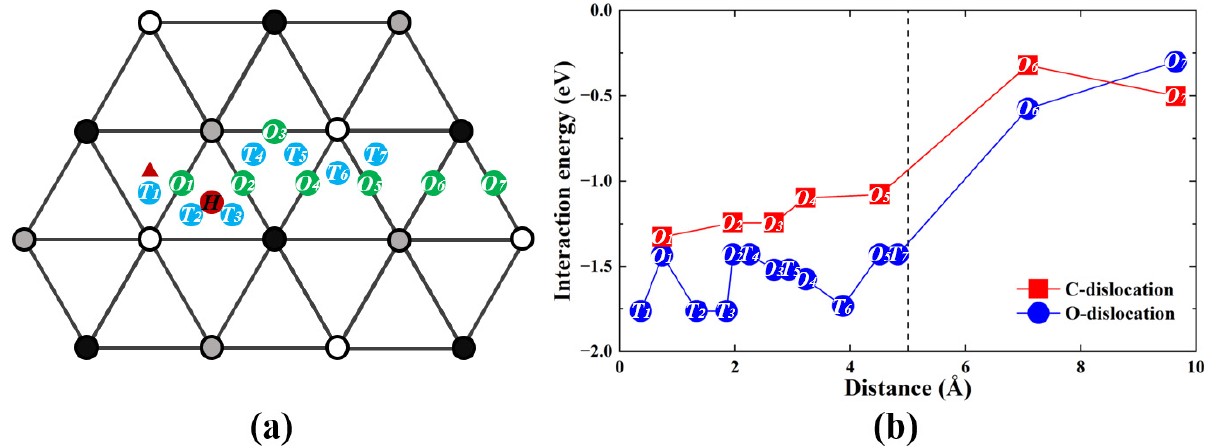
Figure 2. ( a ) Projection along the (111) plane for pure Mo dislocation. The position of dislocation is marked with the red triangle and the position of the reconstructed hard core is marked with H. A total of 7 octahedral-like ( O 1 – O 7 ) and tetrahedral-like ( T 1 – T 7 ) interstitial sites around the dislocation core in pure Mo (without the relaxation of the solute–dislocation interactions) are represented in different colors. ( b ) The interaction energy of the C/O atom with dislocation as a function of initial solute–dislocation distance.